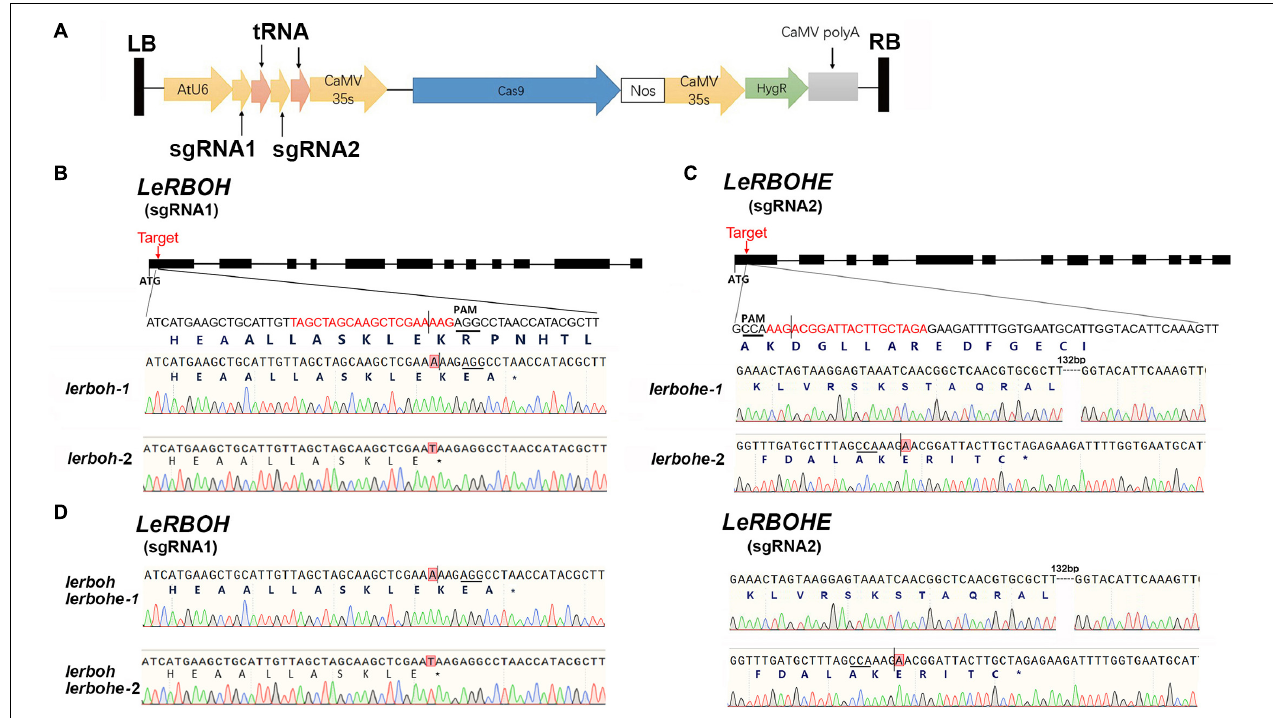
FIGURE 1 | Construction of lerboh/lerbohe via CRISPR/Cas9. (A) Structure of T-DNA insertion containing double sgRNAs for LeRBOH and LeRBOHE , Cas9 driven by the CaMV35S promoter, and HygR (hygromycin resistance gene) as a resistance marker. (B–D) Mutations in the LeRBOH or LeRBOHE locus in lerboh (B) , lerbohe (C) , and lerboh lerbohe (D) mutants. Black squares indicate exons while line segments indicate introns in the sketch maps of the LeRBOH/LeRBOHE genes (top). The protospacer is marked as red while the PAM is underlined. In the Sanger sequencing results, short vertical lines indicate cleavage sites by Cas9 in the LeRBOH/LeRBOH genes. Inserted bases are highlighted. The dotted lines represent deletions in the mutants. * means stop